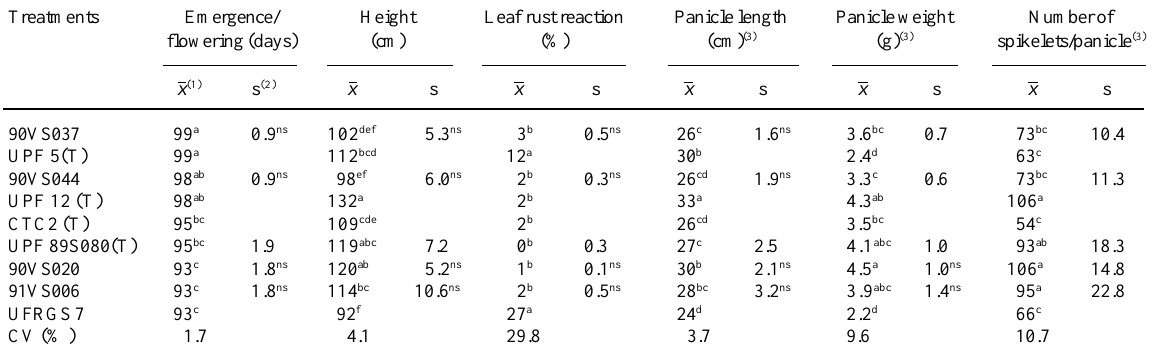
Table V - Comparison between means and standard deviations from oat somaclones derived from cultivar UPF 89S080 and controls. Evaluated traits were: days between emergence and flowering, plant height, leaf rust reaction, panicle length and weight and number of spikelets per panicle. Experiment 3. EEA/UFRGS, Eldorado do Sul, RS, 1994.